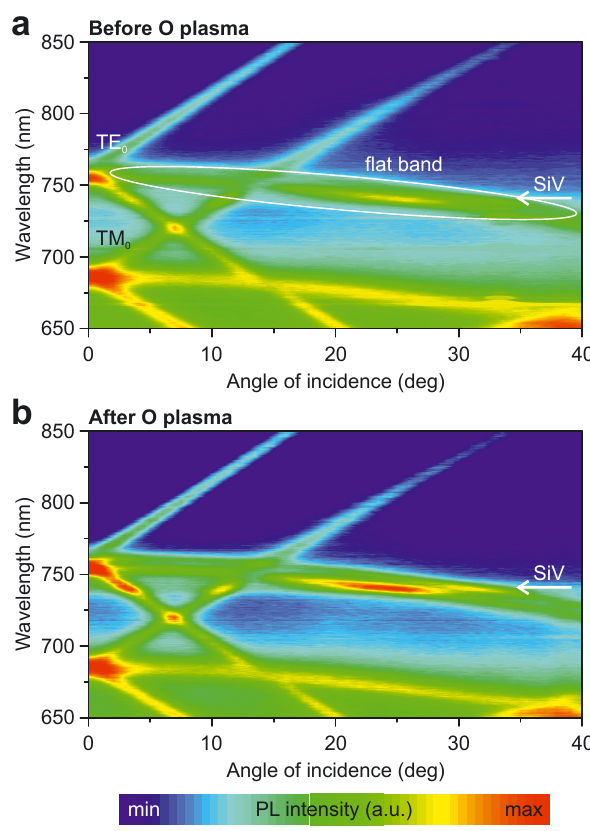
Figure 5: Angle-resolved photoluminescence (PL) along the Γ – X direction (a) before and (b) after the oxygen plasma